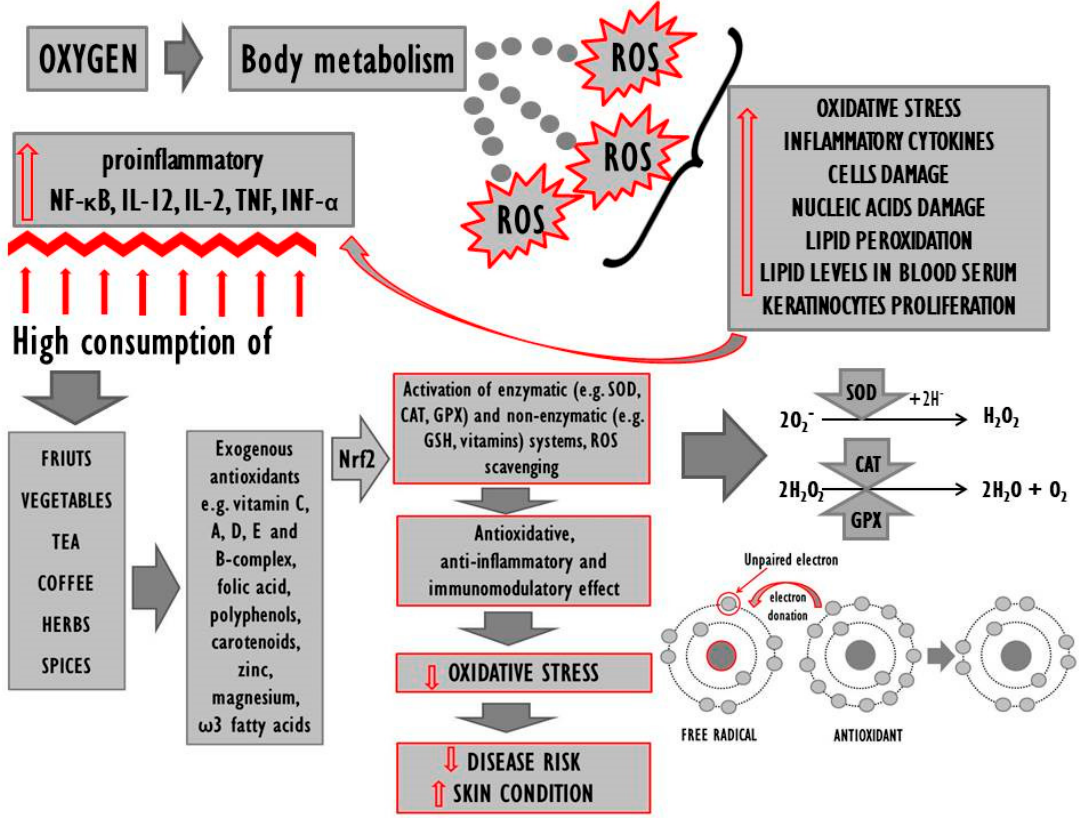
Figure 2. The effects of dietary supplementation with antioxidants in patients with psoriasis. Figure 2. The e ff ects of dietary supplementation with antioxidants in patients with psoriasis.